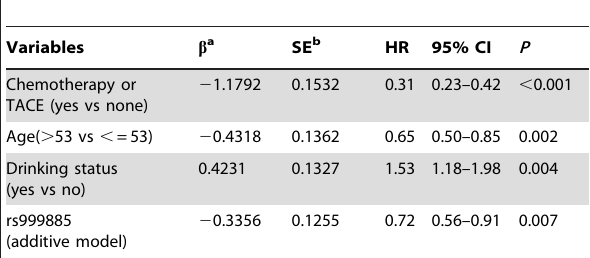
Table 3. Stepwise Cox Regression analysis on HCC survival.